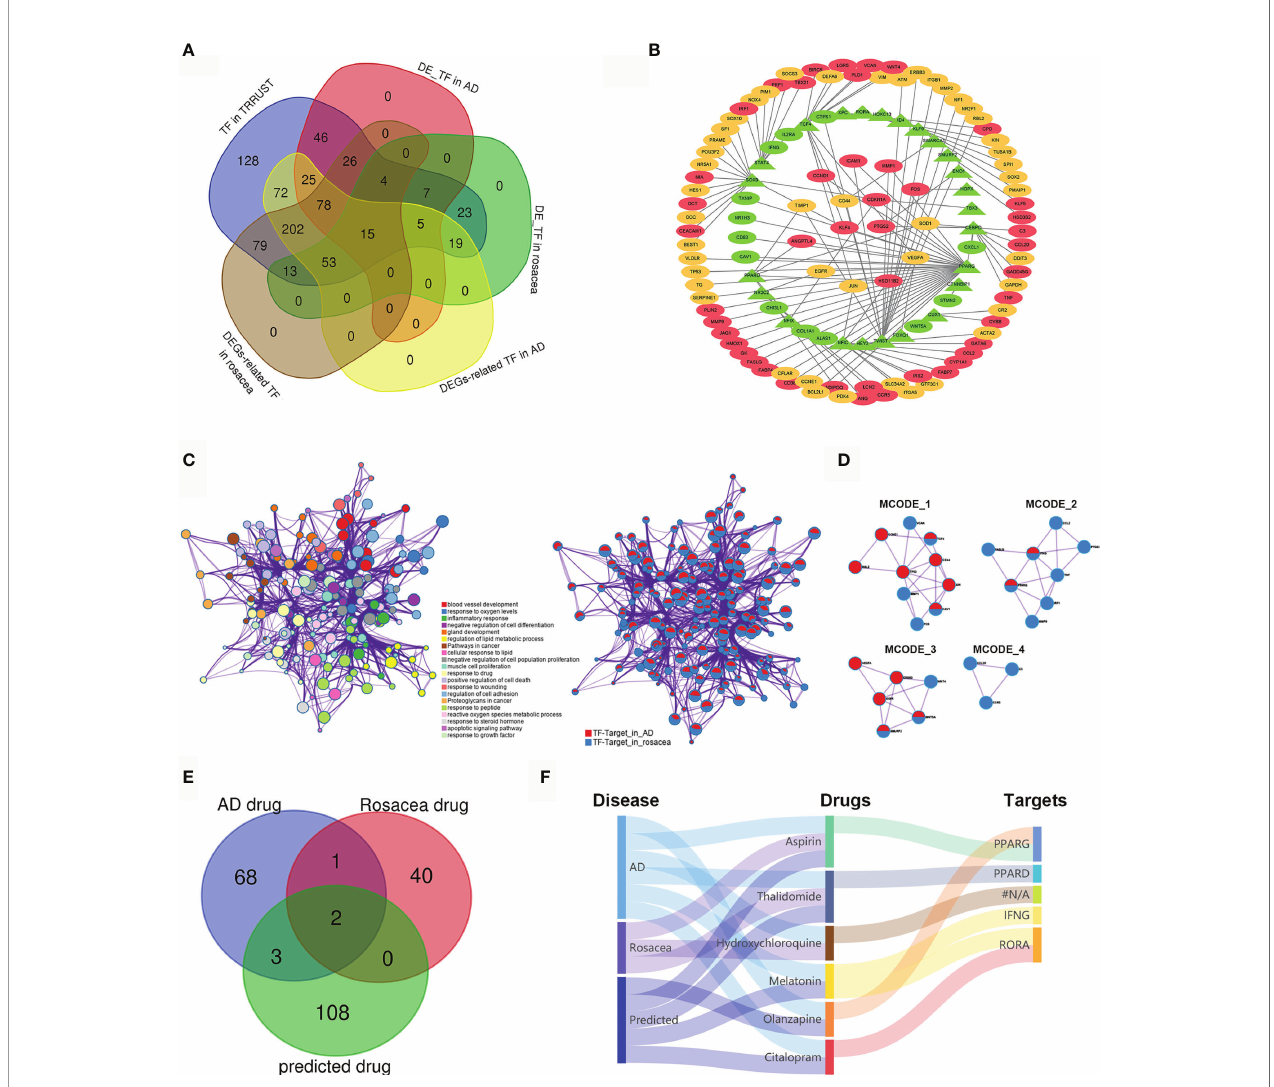
FIGURE 3 | The TF regulatory network and candidate drugs for AD and rosacea. (A) The common TFs in AD and rosacea. (B) The TF regulatory network in AD and rosacea. (C) The enrichment of TF – target genes using the Metascape database. Network of enriched terms colored by cluster ID and the identities of the gene lists. (D) MCODE components identi fi ed in TF – targets in rosacea and AD. (E) The Venn diagram revealed the intersection among AD drugs, rosacea drugs, and predicted drugs. (F) The Sankey diagram revealed the correlation between the disease, drugs, and targets.